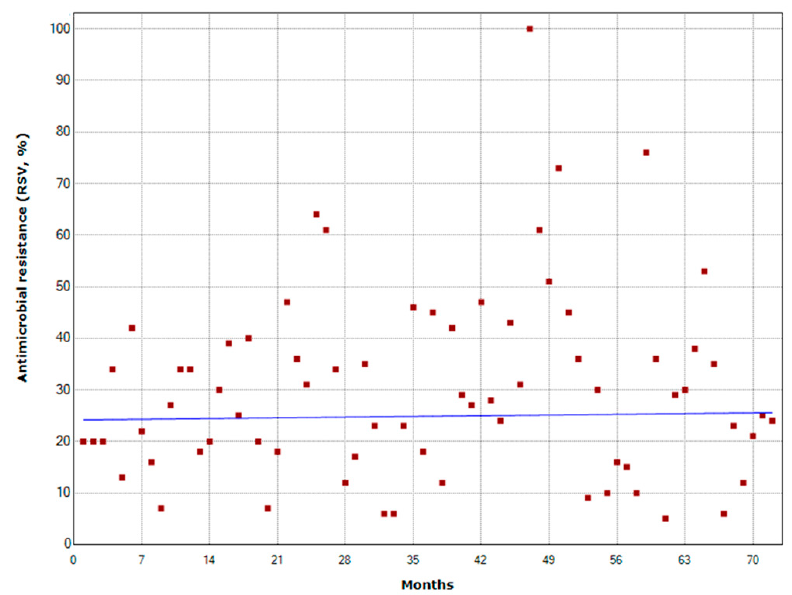
Figure 3. Joinpoint analysis of public interest in the term “antimicrobial resistance”.